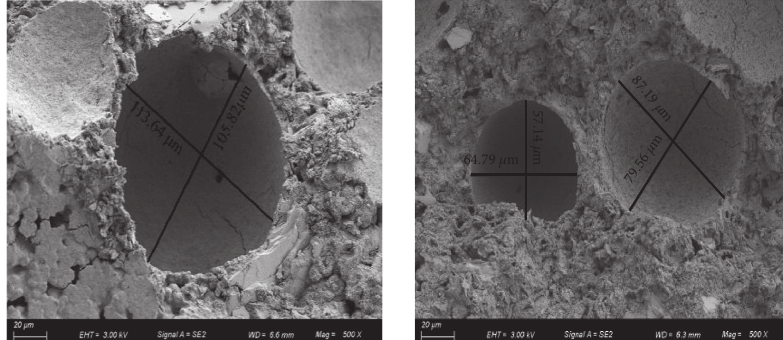
Figure 7: Photograph of 28d hydration of the specimen when scanned by electron microscope at 500x.